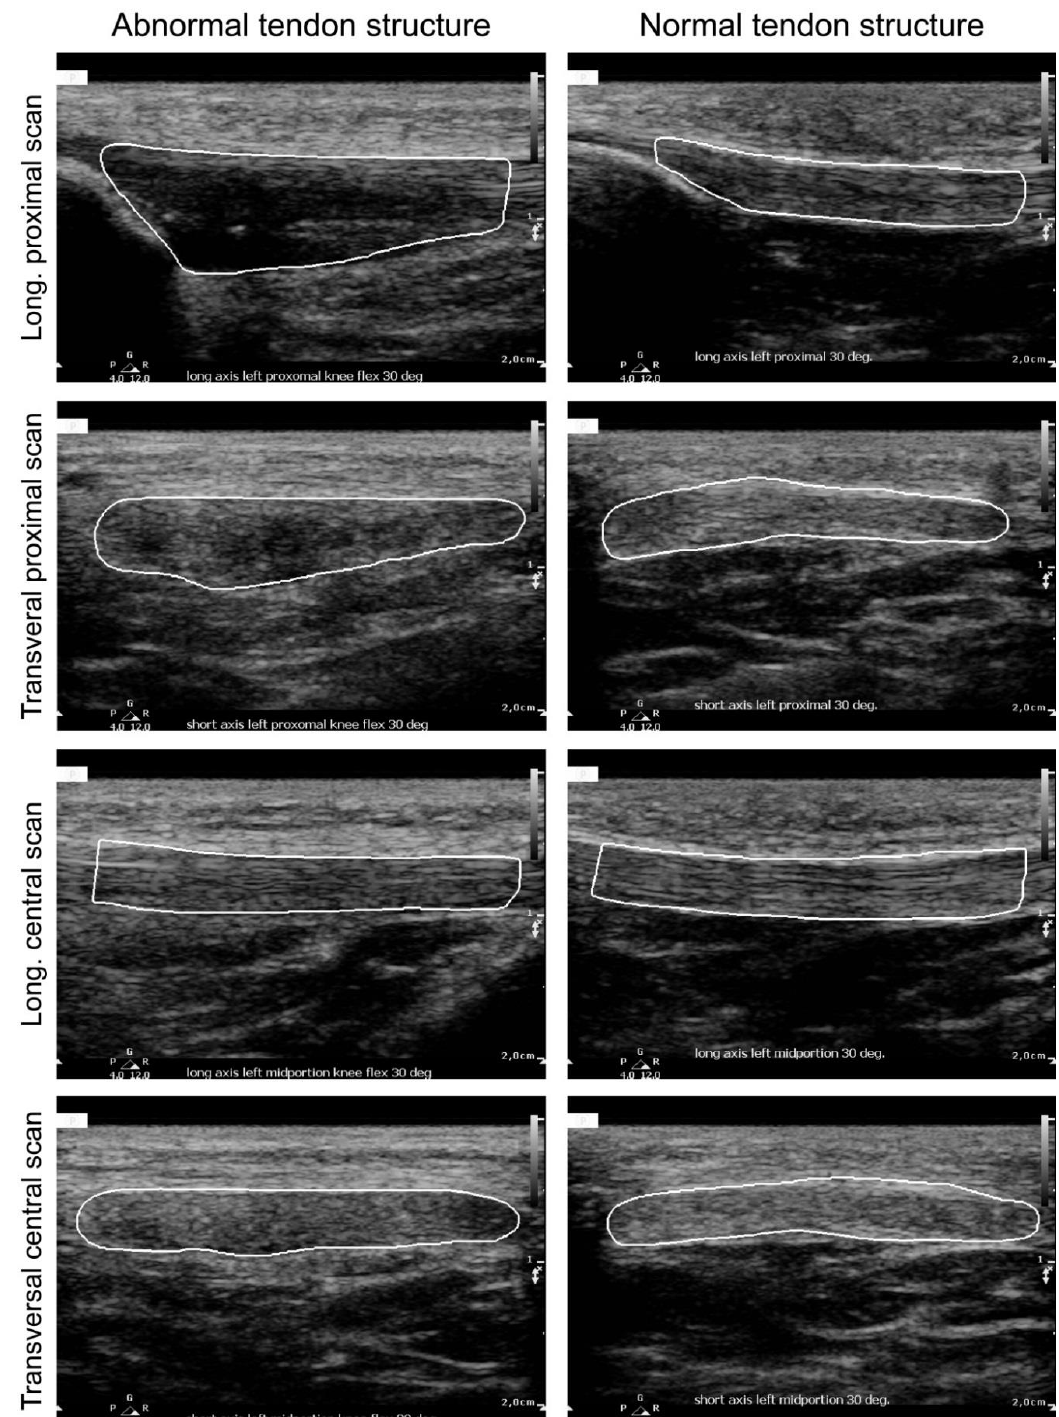
Figure 2. Representative patellar tendon images showing the non-dominant side of two players, one with a normal tendon structure ( right panels ), and one player with an abnormal tendon structure ( left panels ). An abnormal tendon structure was taken as one that fell into the category of subclinical tendinopathy as arbitrarily defined in the study by Giacchino et al. [23]. All scans reported in the figure were acquired with the knee at a 30° position. Long: longitudinal.